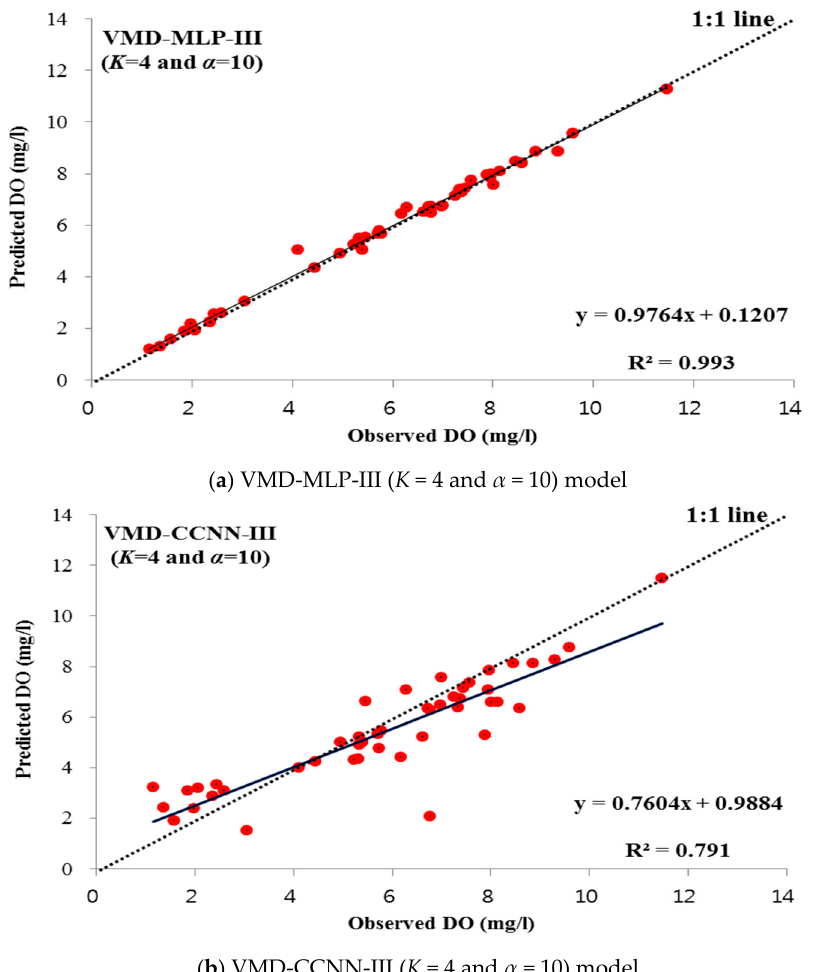
Figure 12. Scatter plots of observed and predicted DO values using VMD-based soft computing models for the testing phase.